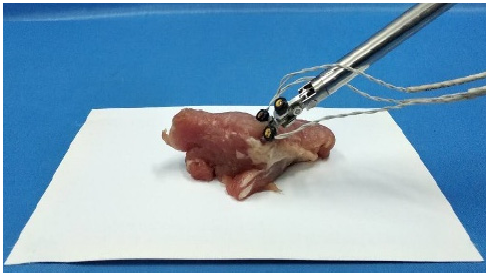
Figure 13. Validation of the transmission backlash compensation for the surgical instrument.